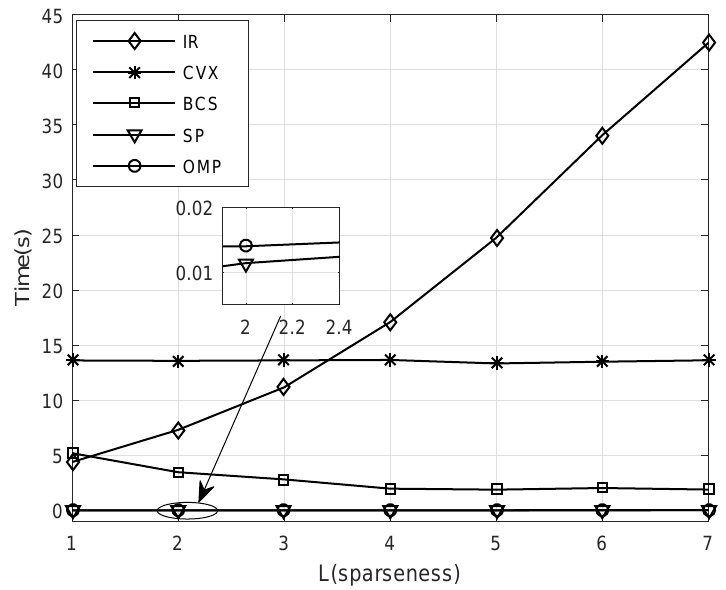
Figure 8. Runtime of the estimation algorithms versus the sparseness with received SNR = 10 dB, angle quantization G = 32, pilot symbol frames M = 16 and without hardware